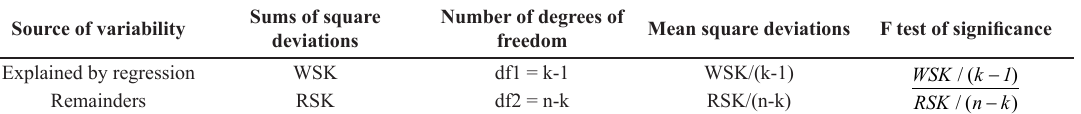
Table 2. ANOVA table Source of variability